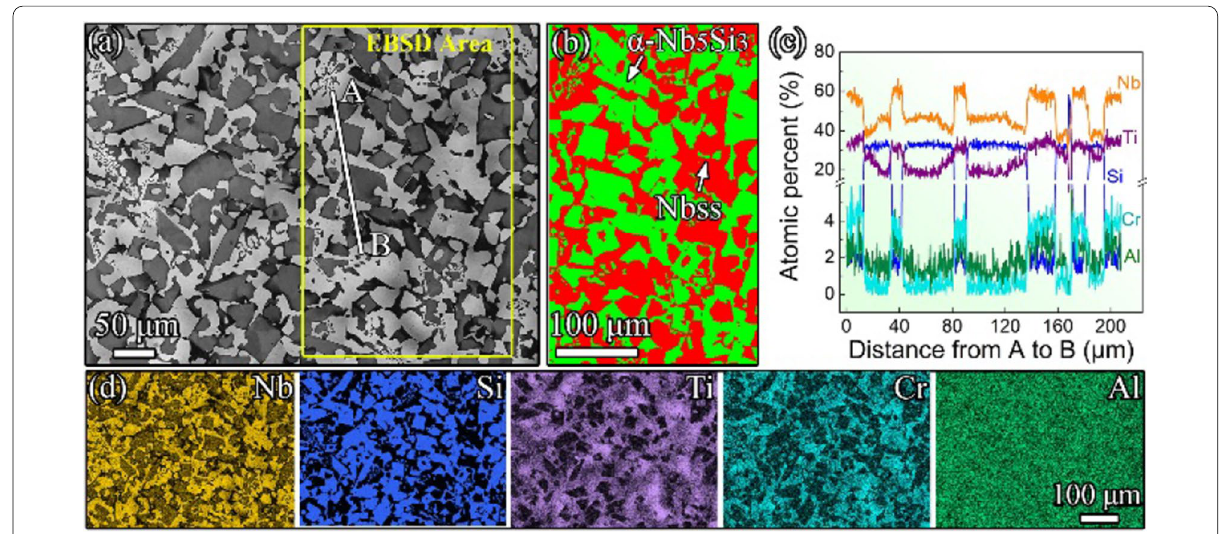
Figure 2 Microstructures and elemental distributions of the hypereutectic Nb-Si based alloy via VIM: ( a ) BSE image; ( b ) EBSD phase map; ( c ) EDS scanning along line AB plotted in ( a ); ( d ) EDS mappings of ( a